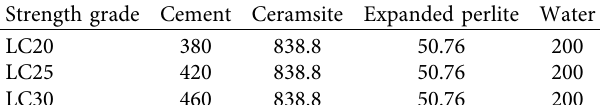
Figure 2: Dimensions of the specimen Z200 series (unit: mm). Table 2: Mixture ratio of lightweight aggregateconcrete (unit: kg/m 3 ).